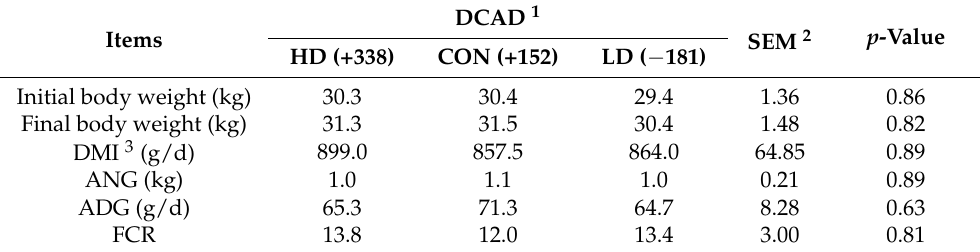
Table 6. Effect of varying dietary cation-anion difference on growth performance of female